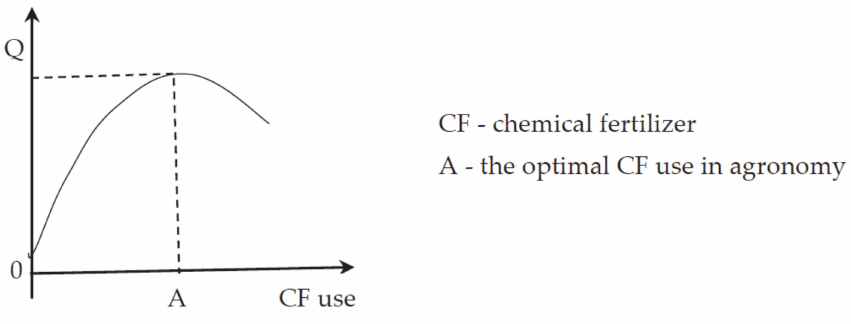
Figure 1. Optimal application of chemical fertilizer (CF) in